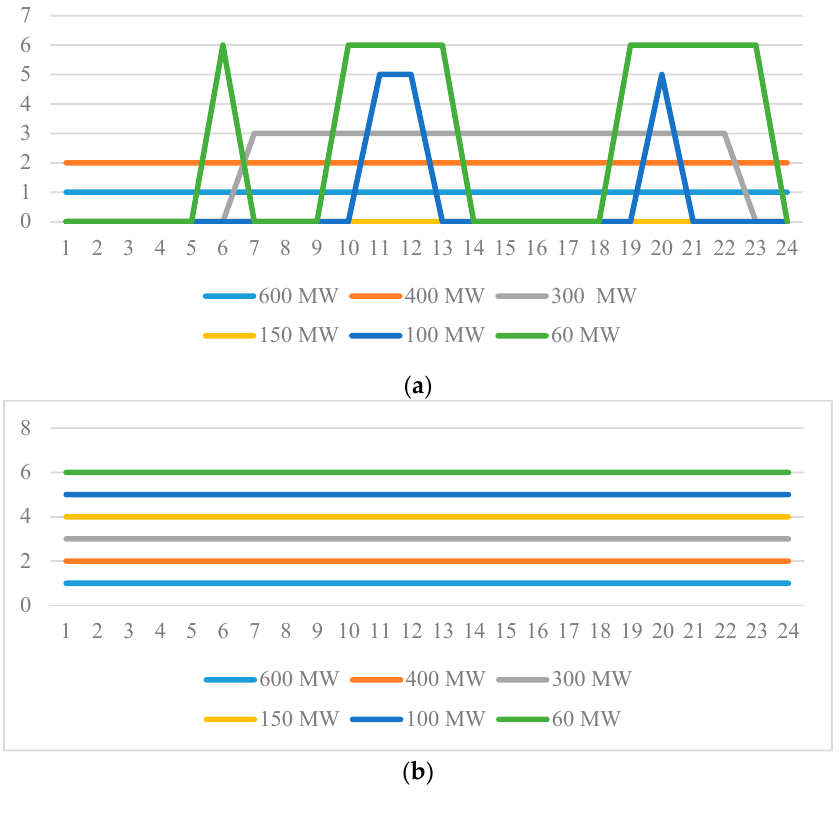
Figure 7. The thermal units’ operating status in both situations. ( a ) Thermal units’ and biomass units’ dispatching system; ( b ) basic dispatching system.